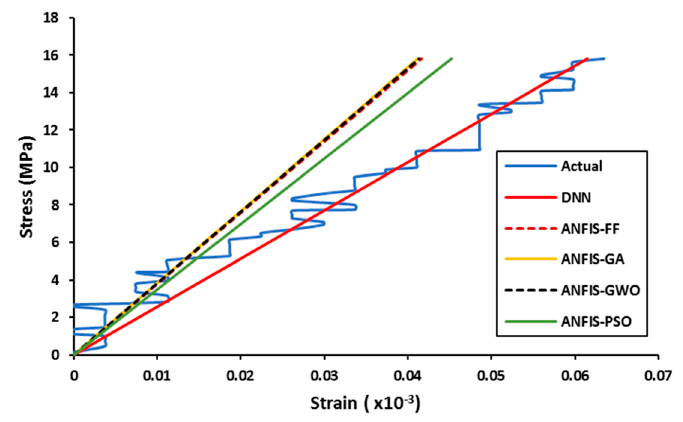
Figure 6. Stress-Strain behavior of rock sample ( 𝑥 direction).